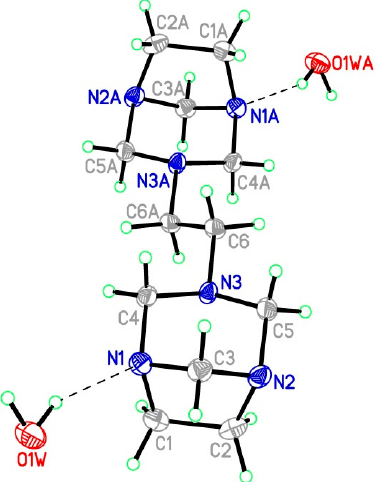
Figure 6. The molecular structure of ETABOC dihydrate. Displacement ellipsoids are drawn at the 50% probability level. Hydrogen bonds are drawn as dashed lines. Atoms labeled with the suffix A are generated using the symmetry operator − x + 1, − y, − z + 2.